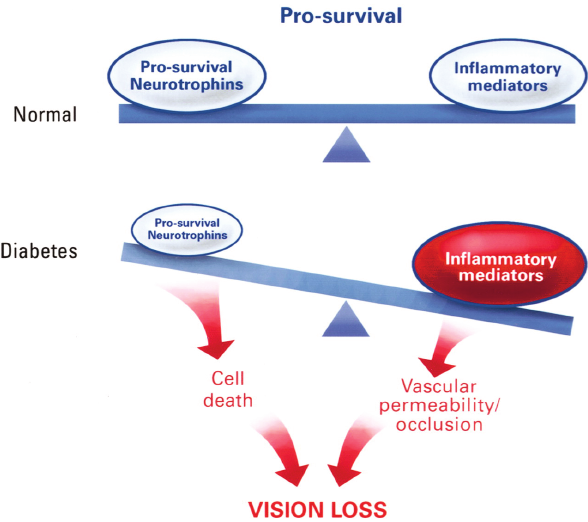
Figure 3: Concept of imbalance between pro-survival factors and inflammatory mediators [15]. Diabetes disturbs the homeostatic equilibrium of the retina. Under normal conditions, there is an equilibrium in which pro-survival and anti-inflammatory stimuli maintain retinal cell survival and function. In diabetes, pro-sur- vival (neurotrophic) inputs may be reduced and pro-inflammatory cytokines, chemokines, and cellular responses increased. Together, these processes accelerate retinal cell death and increase vascular permeability and occlusion, thus impairing vision observed progressive thickness loss of the nerve fiber layer (NFL), the ganglion cell (GC) and inner plexiform layer (IPL). NFL thickness among DM patients without retinop- athy is presented in Figure 4 [16].